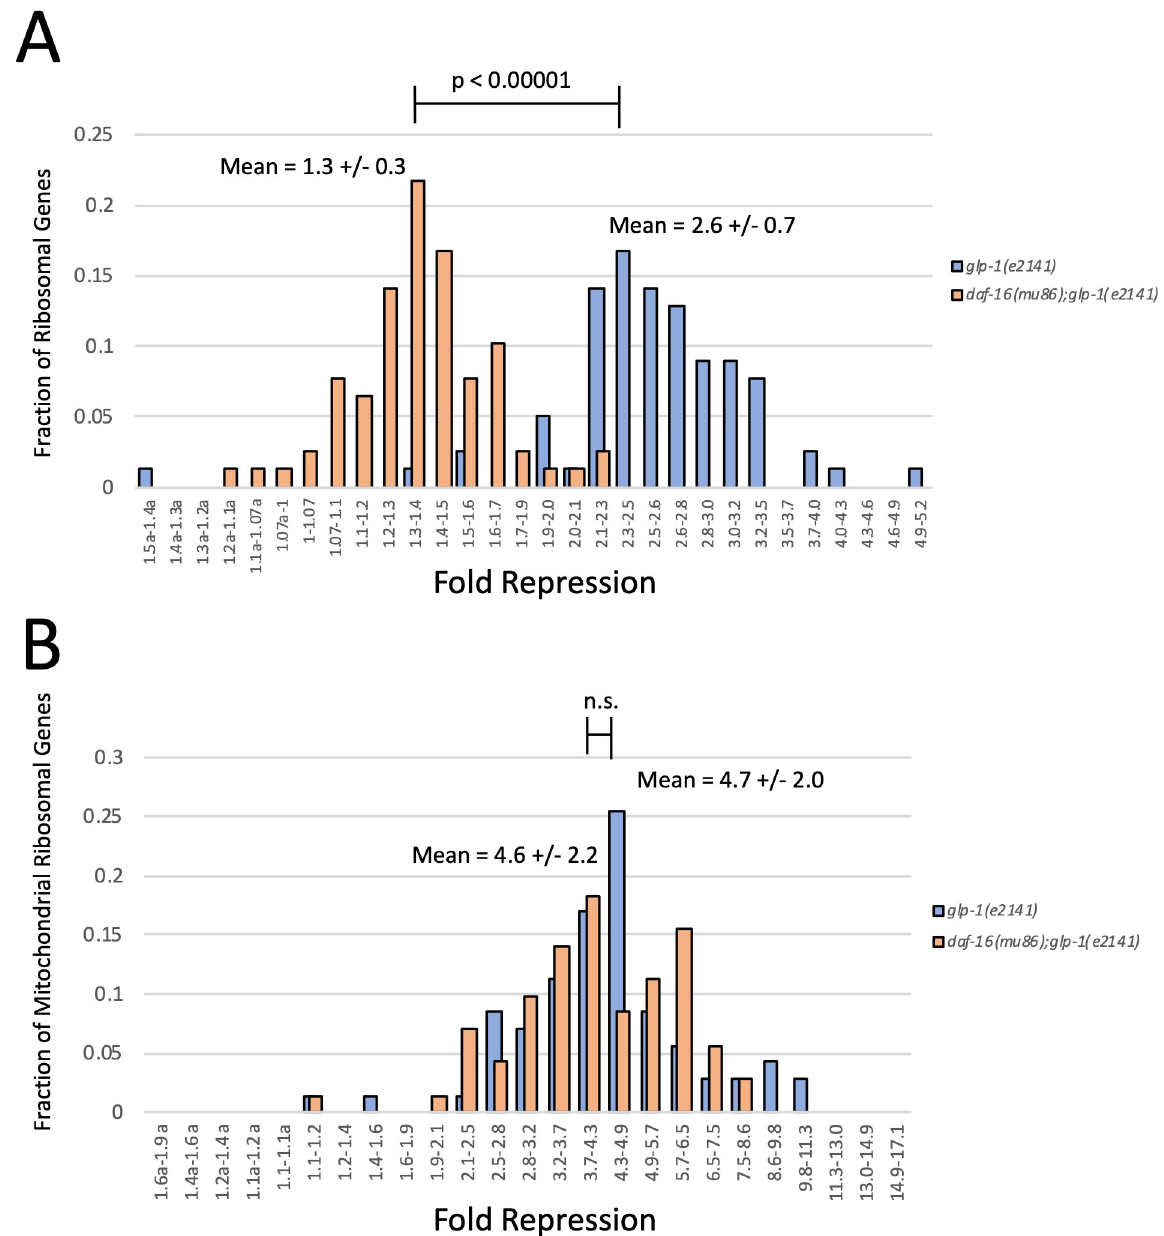
Fig 6. Mutation of daf-16 Specifically Suppresses the Repression of cRPGs in Day 3 Adults. Histograms of cytosolic ribosomal protein genes binned by fold repression between L4 and day 3 of adulthood. Data represent the fraction of cRPGs residing in each range of repression. Blue bars represent cRPGs from a glp-1(e2141) mutant and orange bars represent cRPGs from a daf-16(mu86);glp-1(e2141) double mutant. Data show that cRPGs are significantly repressed (mean = 2.6-fold) in glp-1(e2141) animals, however repression of cRPGs in the glp-1(e2141) mutant is nearly eliminated by mutation of daf-16 (P value < 0.00001). (B) Histograms of mitochondrial ribosomal protein genes binned by fold repression in day 3 adults. Blue bars represent mRPGs from a glp-1(e2141) mutant and orange bars represent mRPGs from a daf-16(mu86);glp-1 (e2141) double mutant. Data show that mRPGs are repressed in the glp-1(e2141) mutant (mean = 4.7-fold). In contrast to cRPGs, however, repression of mRPGs in day 3 animals is not impacted by mutation of daf-16 . RNAseq data are derived from 4 replicates of the daf-16(mu86); glp-1(e2141) double mutant and 5 replicates of the glp-1(e2141) mutant. Statistics were calculated using a T-test for two independent means. E.g., the mean of cRPGs vs the mean of total genes.